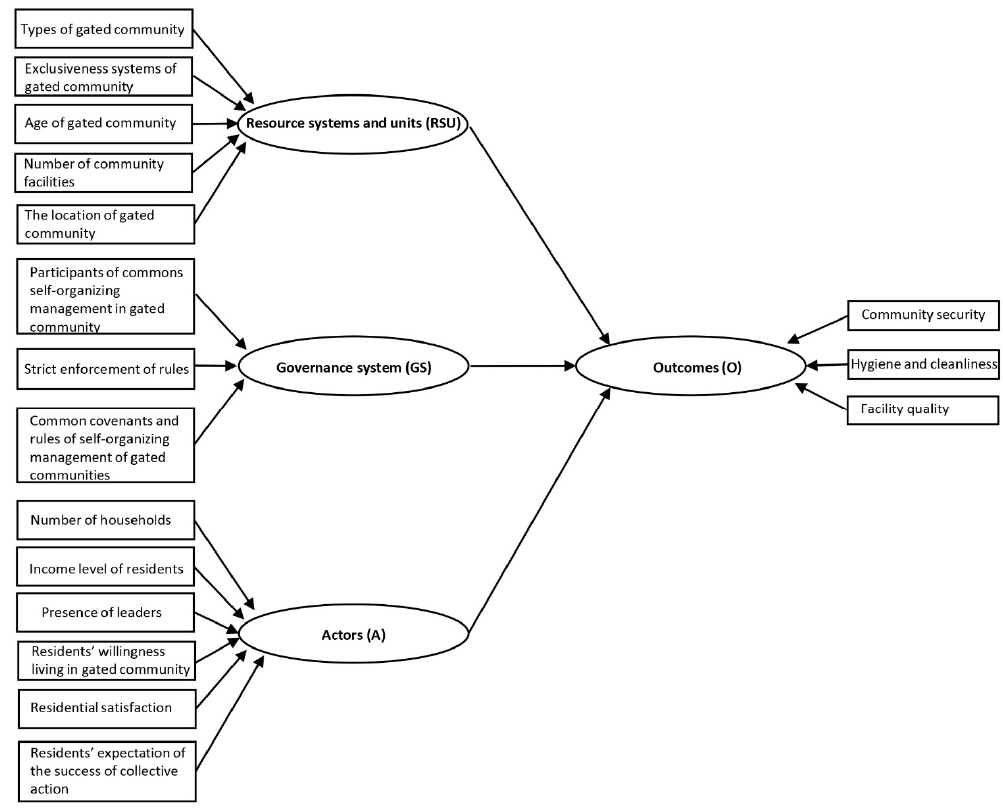
Figure 2. Conceptual framework. Table 2. Information of variables researched in this study.